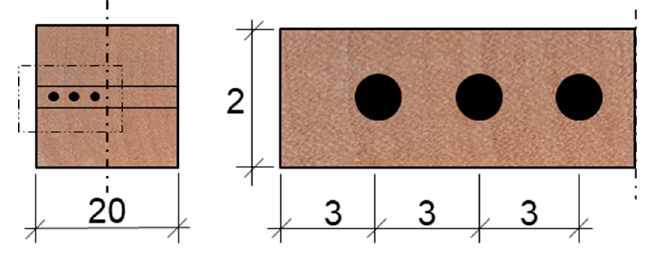
Figure 1. Sample geometry and measuring spots for energy dispersive X-ray analysis (EDX) used to determine the elementary distribution of sodium chloride within the sample cross section.